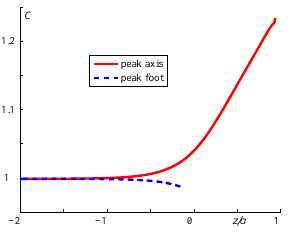
Figure 3. Distribution of the field in- tensity over the peak axis ( r = 0 ) at γ = 1 . 265 in comparison with a flat layer at γ < γ c .